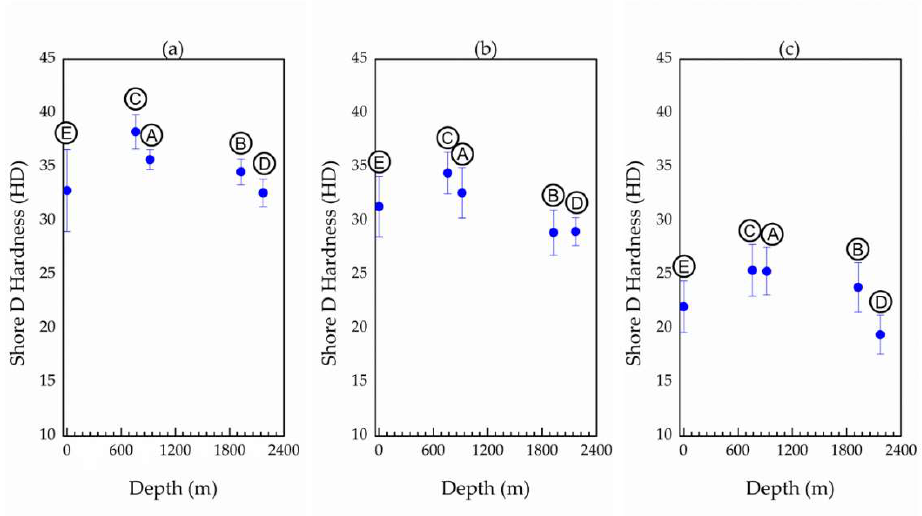
Figure 8. Hardness ( a ) along a longitudinal section of the insulation layer, ( b ) along a transversal section of the insulation layer, and ( c ) of the jacket layer. A–E stand for different ESP cables as denoted in the Experimental section.